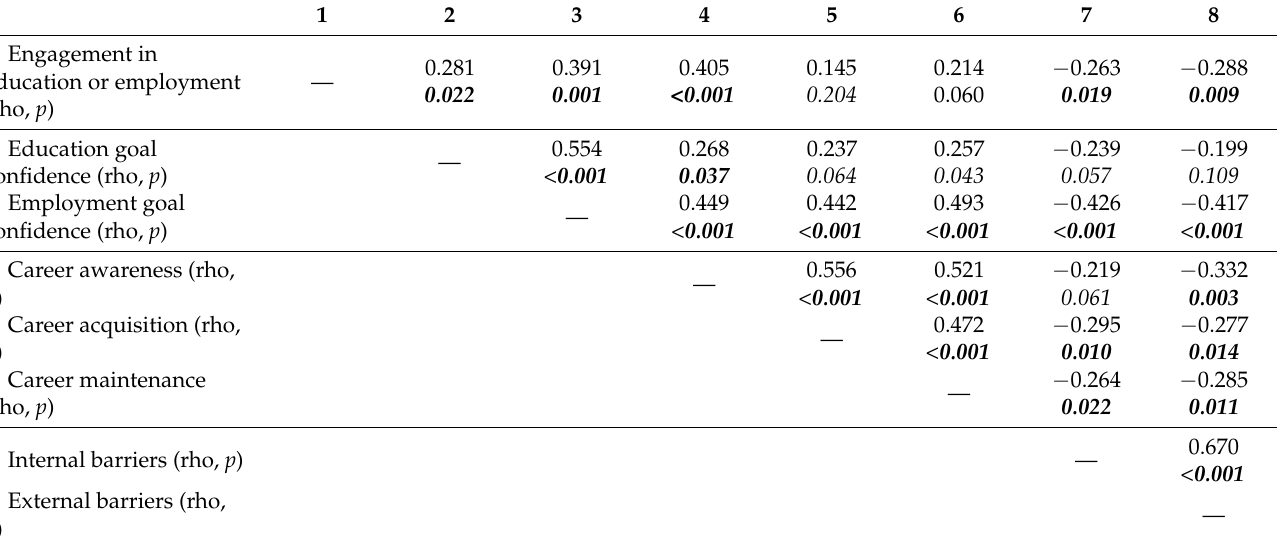
Table 2. Correlations between measures of education and employment participation, goals, career development, and perceived barriers .